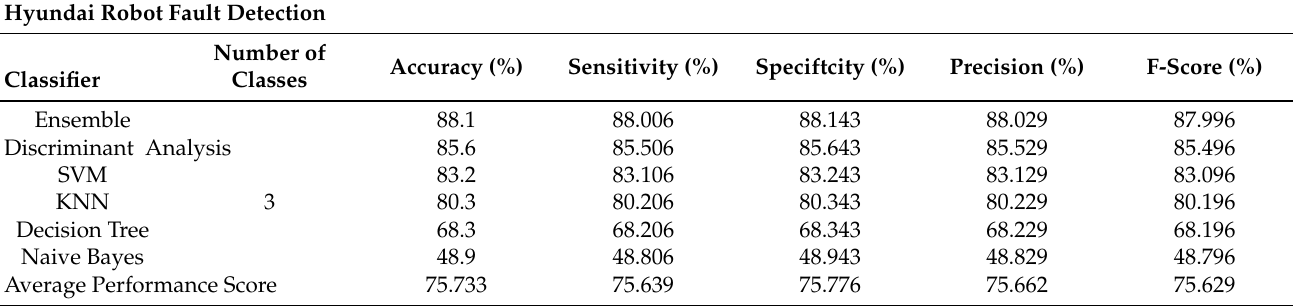
Table 2. Classifiers performance score for Hundai robot fault